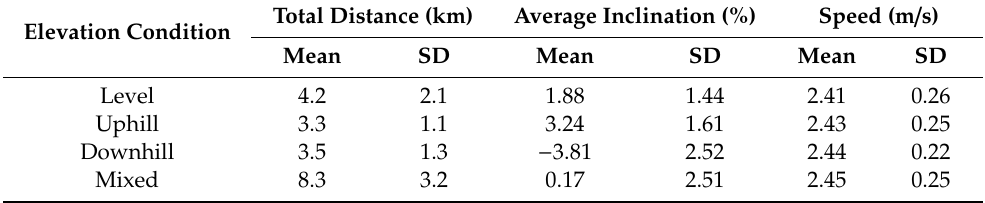
Table 1. Means and standard deviations of the characteristics for each of the four running